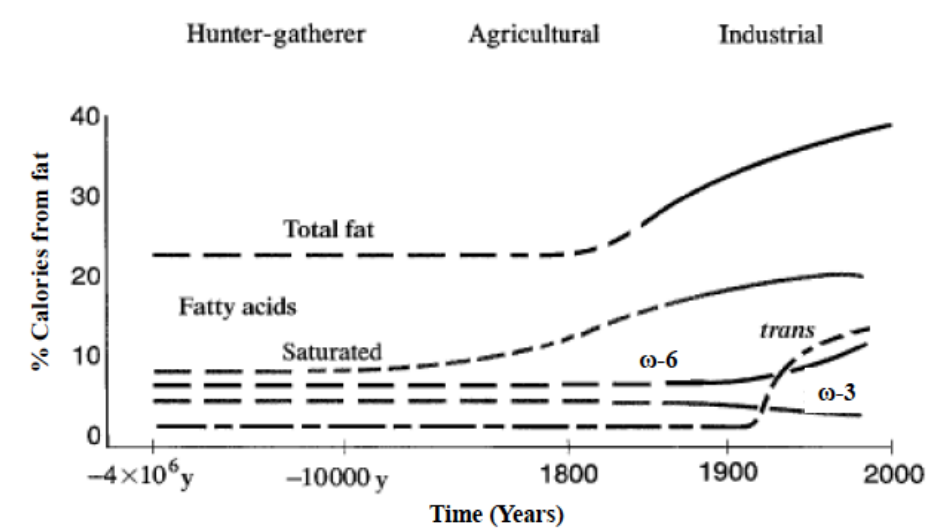
Figure 1. Hypothetical scheme of fat, fatty acid ( ω 6, ω 3, trans, and total) intake (as percent of calories from fat). Data were extrapolated from cross ‐ sectional analyses of contemporary hunter ‐ gatherer populations and from longitudinal observations and their putative changes during the preceding 100 years (Modified from [3]).